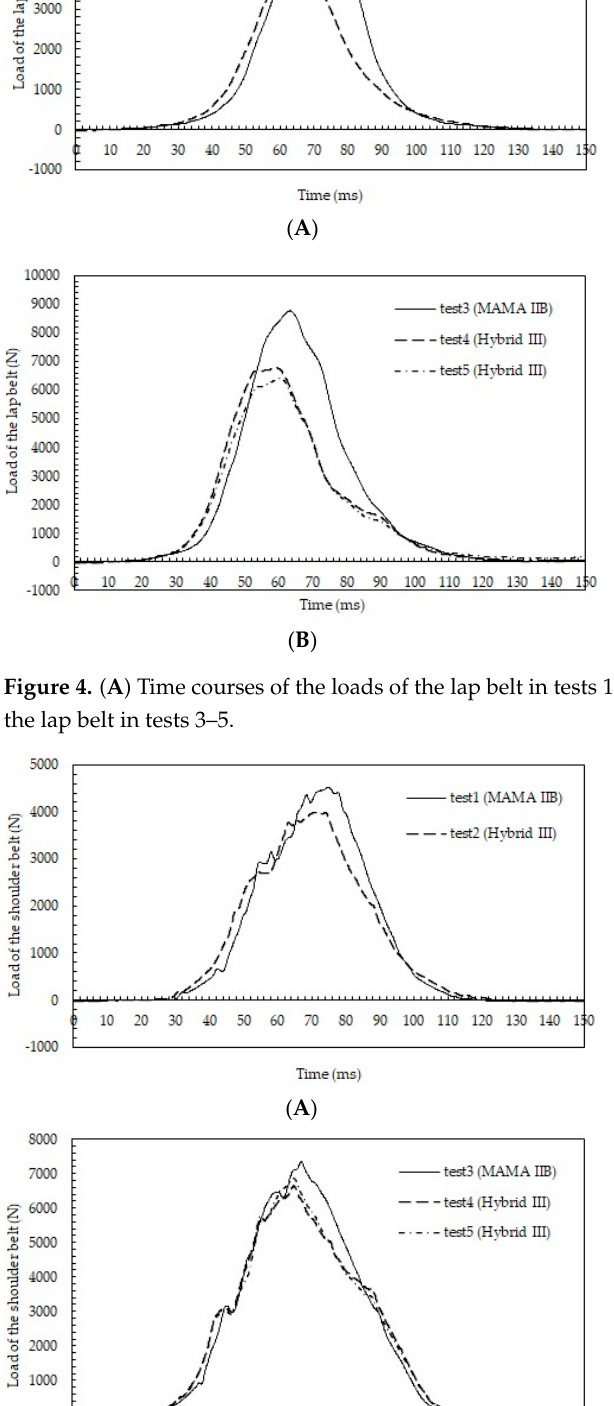
Figure 5. ( A ) Time courses of the loads of the shoulder belt in tests 1 and 2; ( B ) time courses of the loads of the shoulder belt in tests 3–5.